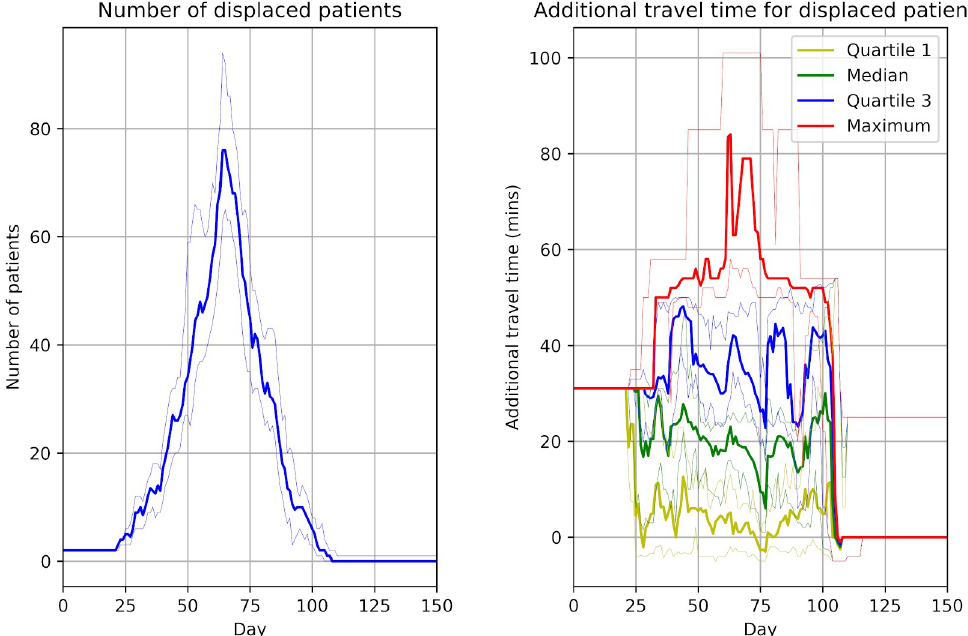
Fig 4. Patient displacement. The number of patients displaced from their current unit (left panel) and the additional travel time to the unit of care (right panel) for displaced patients. These results do not include those receiving inpatient care. The patient population progresses through infection over three months (with 80% infected). The bold line shows the median results of 30 trials, and the fainter lines show the minimum and maximum from the 30 trials.